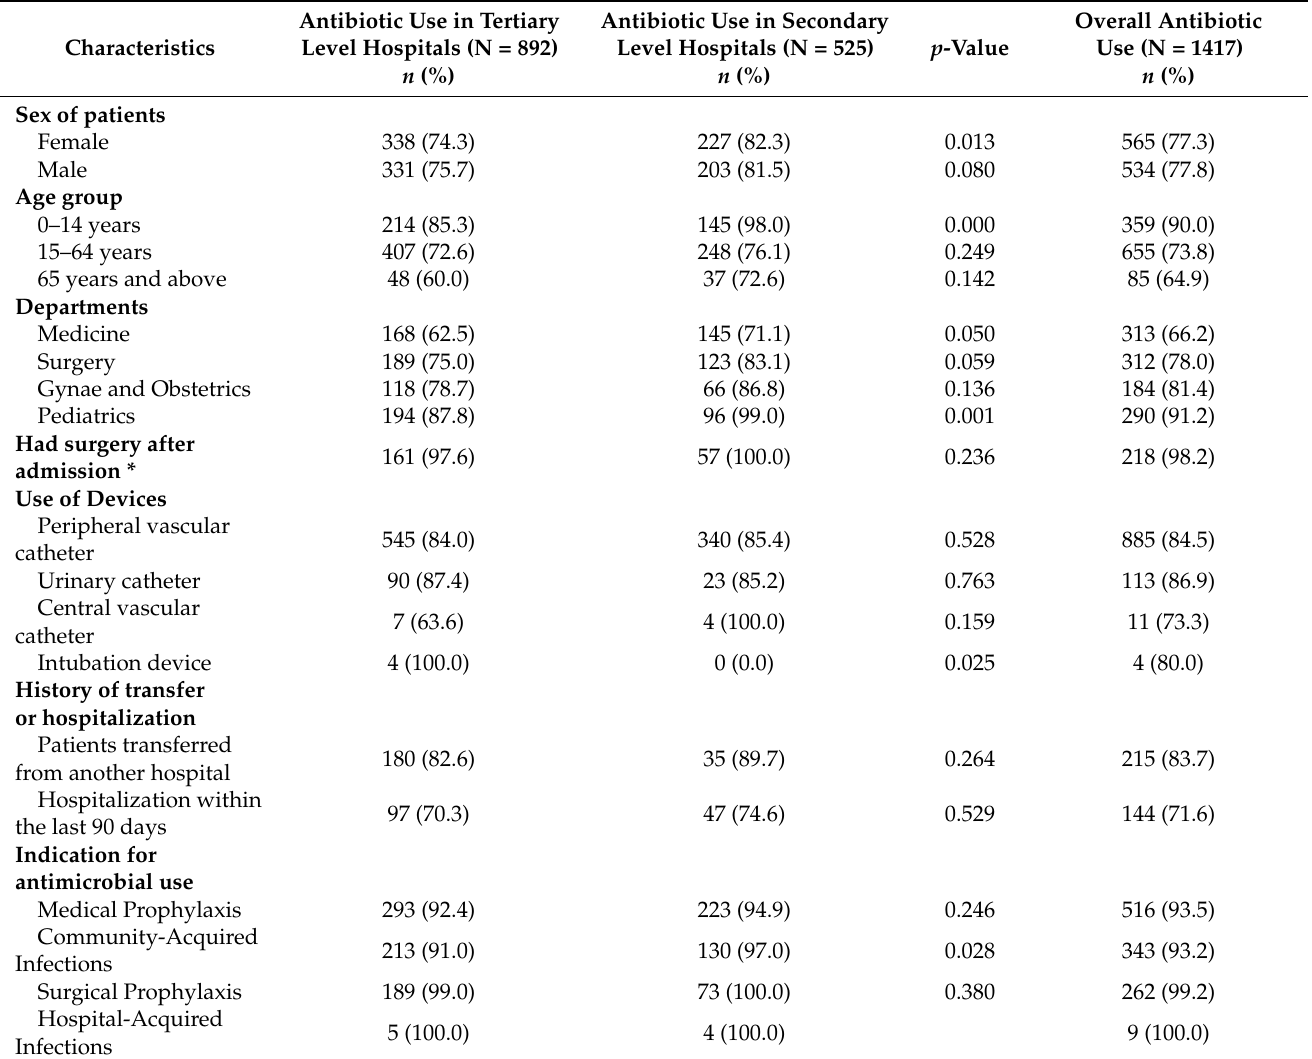
Table 2. Use of antibiotics according to demographic and clinical characteristics of enrolled patients at tertiary and secondary level hospitals in Bangladesh from February to April